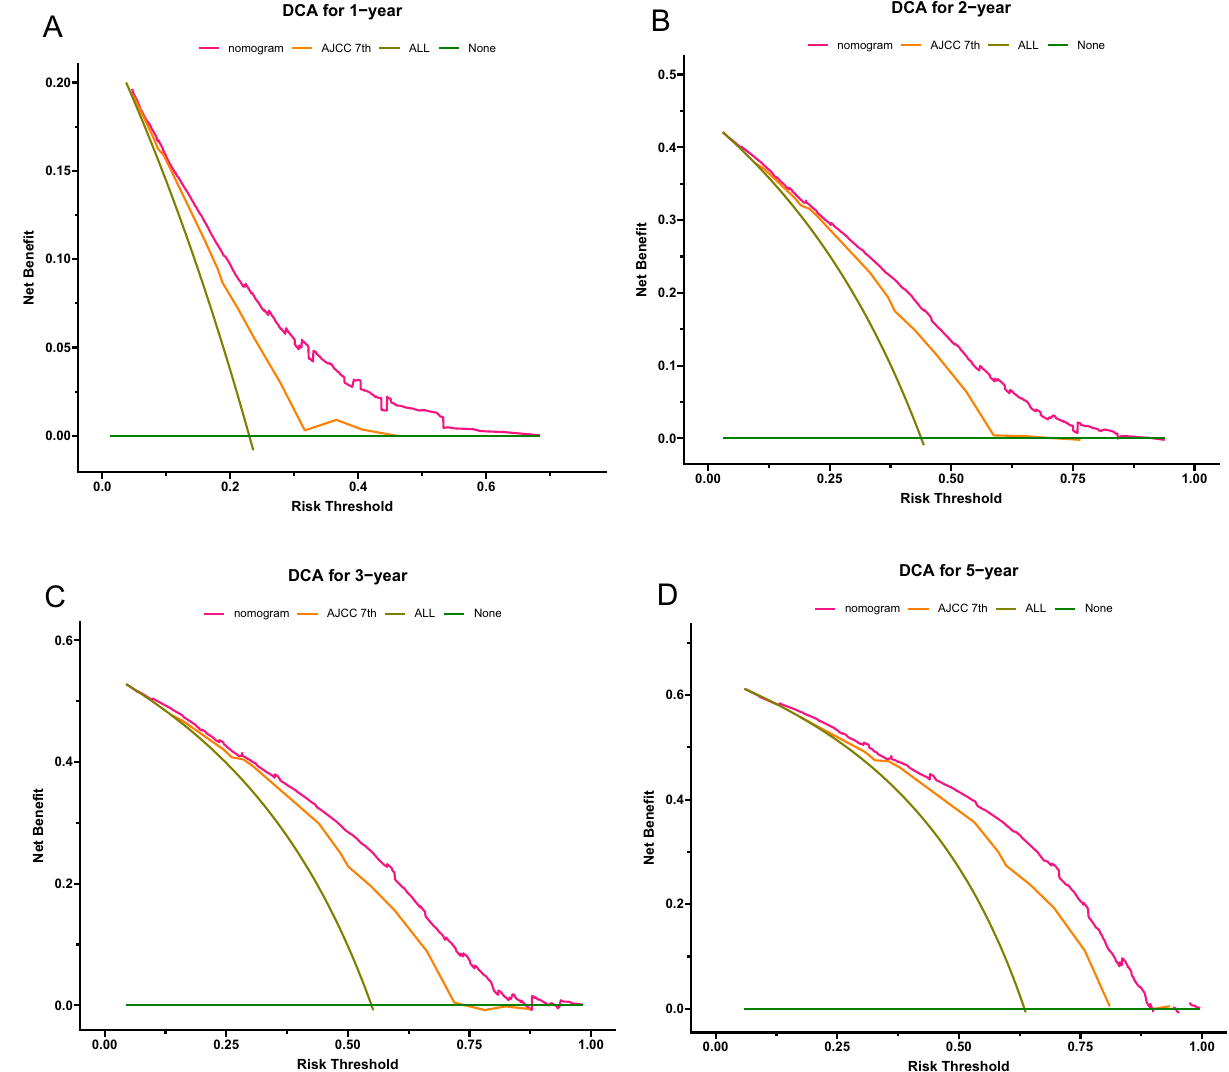
Figure 6. Decision curve analysis in the training cohort of the nomograms and 7th edition AJCC-TNM staging system for predicting 1-, 2-, 3-, and 5-year OS. OS Overall